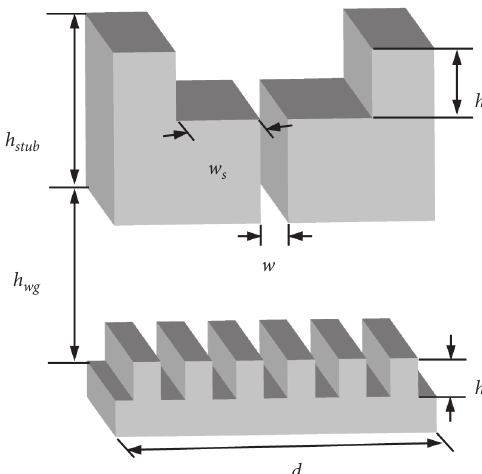
Figure 2: 3D diagram of the